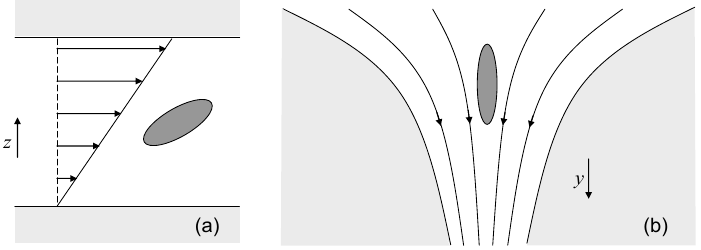
Figure 5. Simple shear flow ( a ) and extensional flow ( b ); image reproduced with permission from Walstra [41].